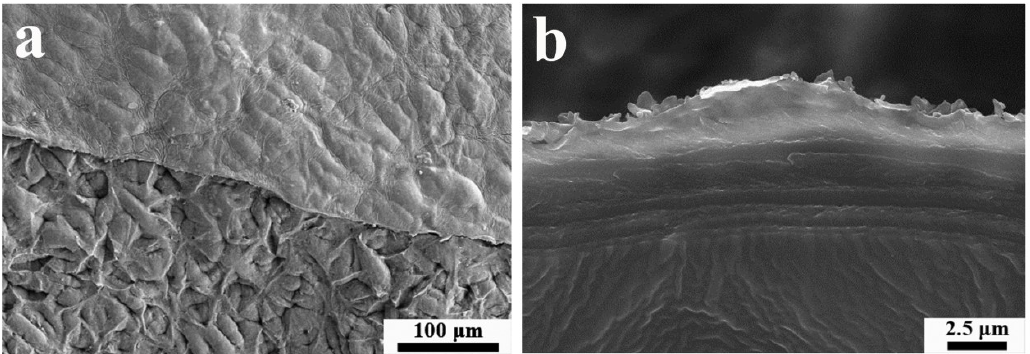
Figure 3. Field emission scanning electron microscopy (FE-SEM) images of multilayer coatings with seven layers on the mango surface ( a ) and a cross-section of the coatings with seven layers ( b ) at 250 × ( a ) and 6000 × ( b ) magnification, respectively.